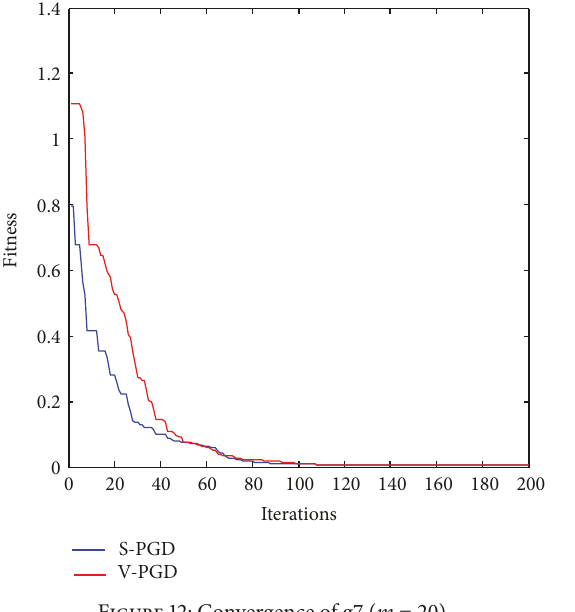
Figure 14: Convergence of g K ( m = 50).